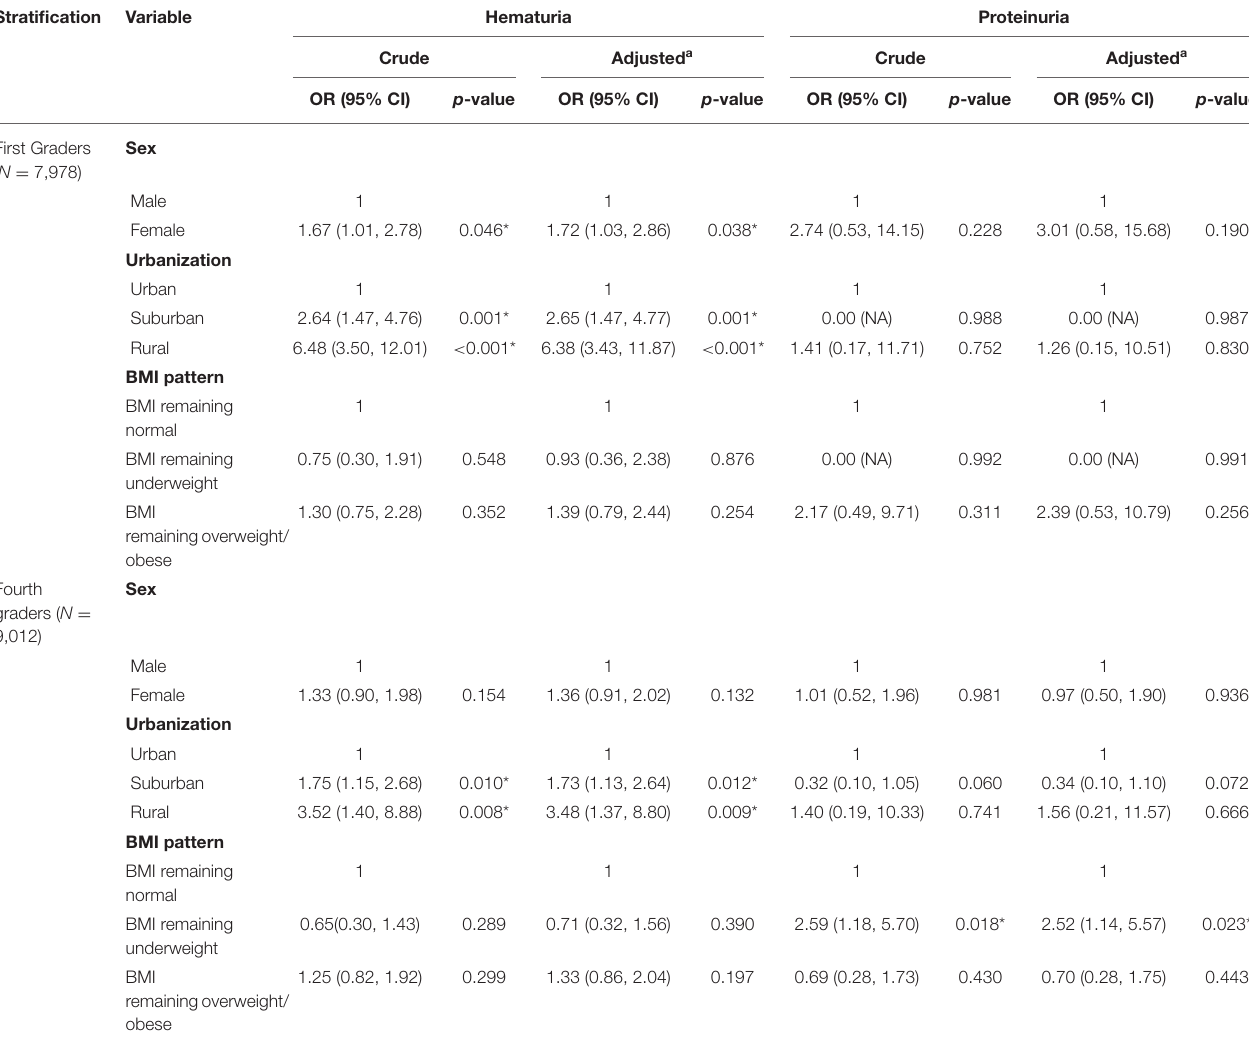
TABLE 3 | Factors associated with a higher risk of abnormal screening items, stratified for grade ( n =